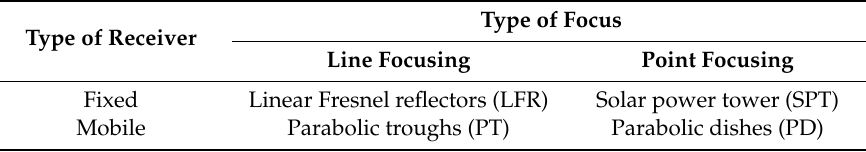
Table 1. Classification of CSP technologies [18–20].